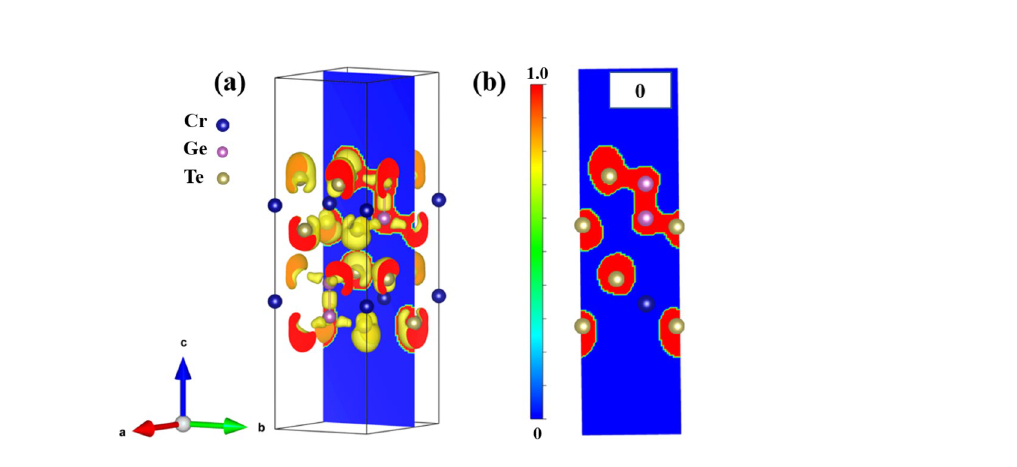
− − l a and l b versus strain.